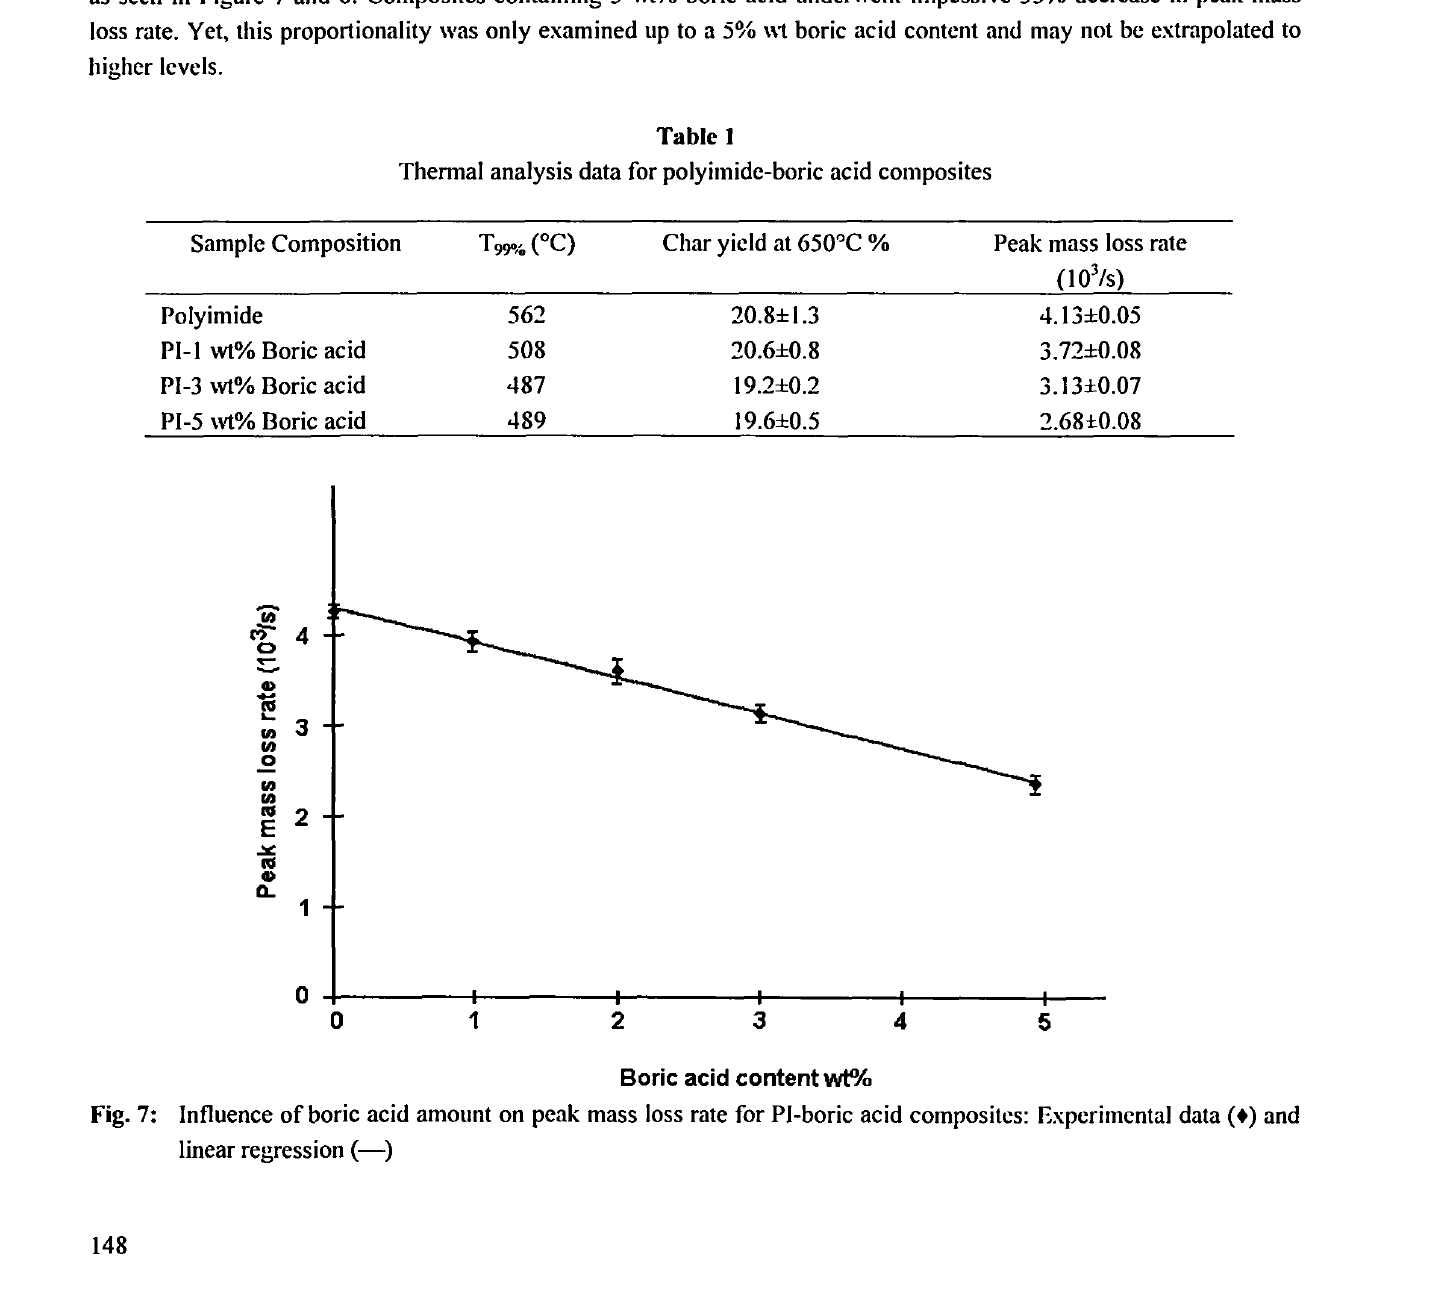
Fig. 7: Influence of boric acid amount on peak mass loss rate for Pi-boric acid composites: Experimental data (*) and linear regression